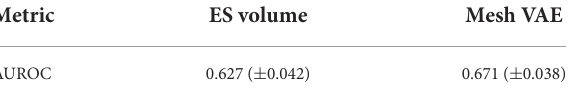
TABLE 4 Results of binary MACE